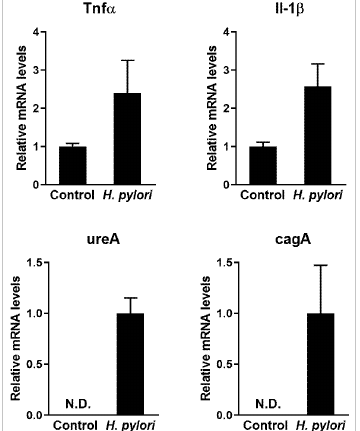
Figure 2. Expression levels of tumor necrosis factor alpha (Tnf α ), interleukin-1 beta (Il-1 β ), urease subunit alpha (ureA), and cytotoxin-associated gene A (cagA) mRNA in mouse gastric tissue following Helicobacter pylori Sydney Strain-1 (SS-1) inoculation. H. pylori SS-1 was administered to C57BL/6 mice for 30 days. N.D., not detected.